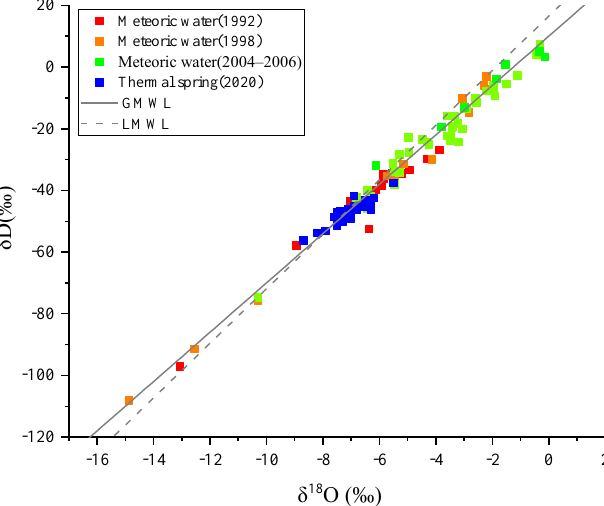
Figure 5. Scatter plot of the δ D and δ 18 O values from the sampled thermal springs and meteoric water. The red, orange and green squares represent the δ D vs. δ 18 O for the local precipitations of 1992, 1998 and 2004–2006, respectively [43–45], and the blue square represents the δD vs. δ 18 O for the thermal springs in this work.